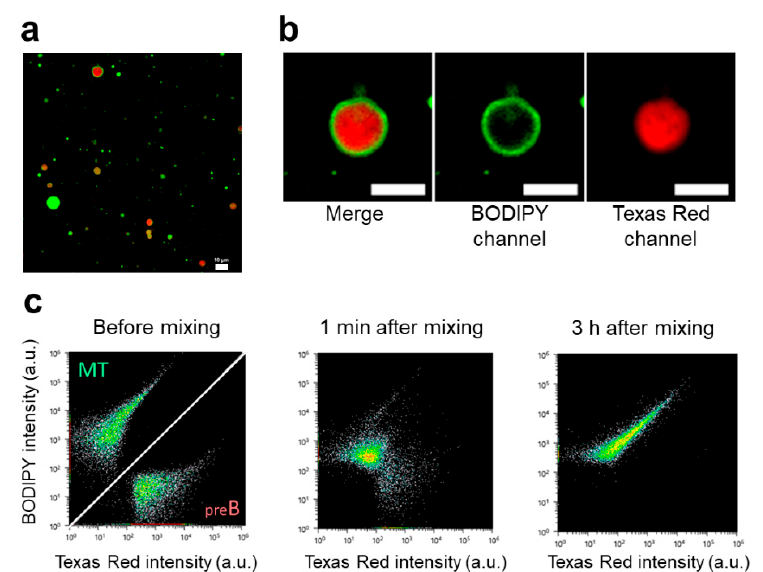
Figure 3. Intervesicular dynamics regarding coating pre-BD by MT. Confocal microscopy image of a mixed dispersion of MT tagged with BODIPY-HPC and pre-BD tagged with Texas Red-DHPE at 6 h after mixing ( a ), Confocal microscopy images of coated pre-BD with MT merged (channel), BODIPY channel, Texas Red channel, Scale bar represents 10 μ m. ( b , left, middle, right), Flow cytometry image of MT and pre-BD before addition of V* , image at 1 min after mixing, image at 3 h after mixing ( c , left, middle, left). 3c left is a combination of two independent images separated by a diagonal white line. The above left image is assigned to the image of MT and the right below to the image of pre-BD before addition of V* .